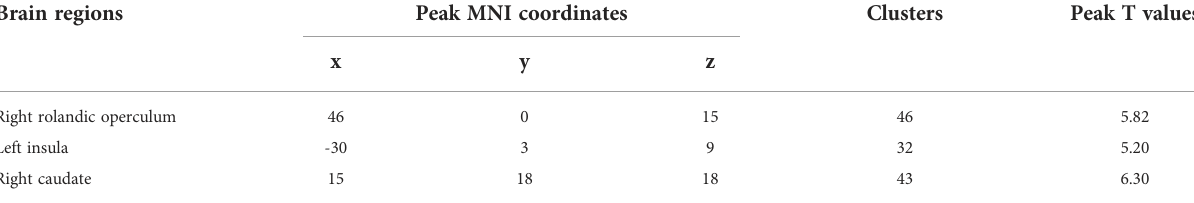
NSCLC, non-small cell lung cancer; HCs, healthy controls; ReHo,regional homogeneity; AAL, anatomical automatic labeling; MNI, montreal neurological institute; x, y and z: coordinates ofpeakvoxelsofclustersintheMNIspace.PeakTvalueswereobtainedbytwo-samplet-tests.Thesigni fi cancethresholdwassetatP<0.001atthevoxel-levelandP<0.05atthecluster-level and were corrected for multiple comparisons using Gaussian Random Field (GRF) theory with a minimum cluster size of 26 voxels (two tailed).